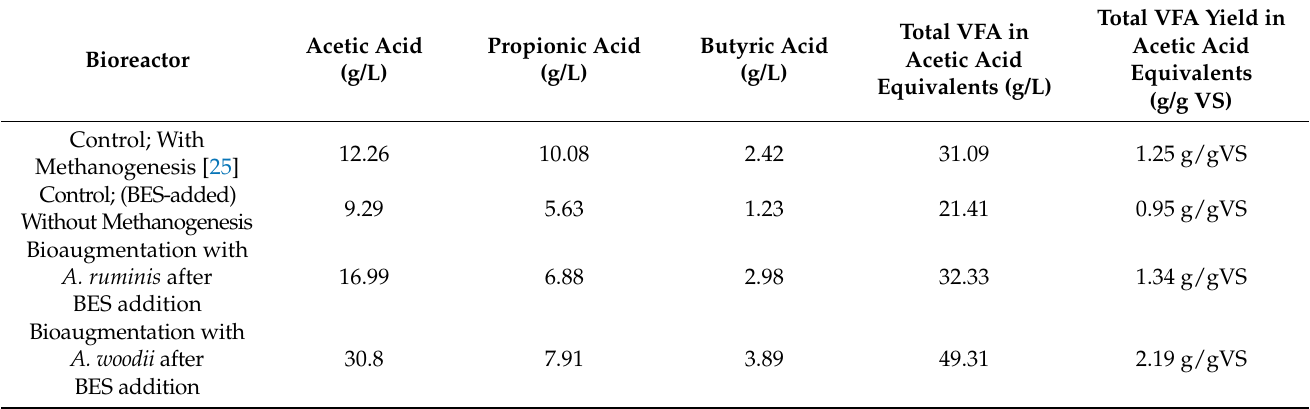
Table 2. Effect of bioaugmentation on VFA fermentation using corn stover as substrate [26] (Table adapted with